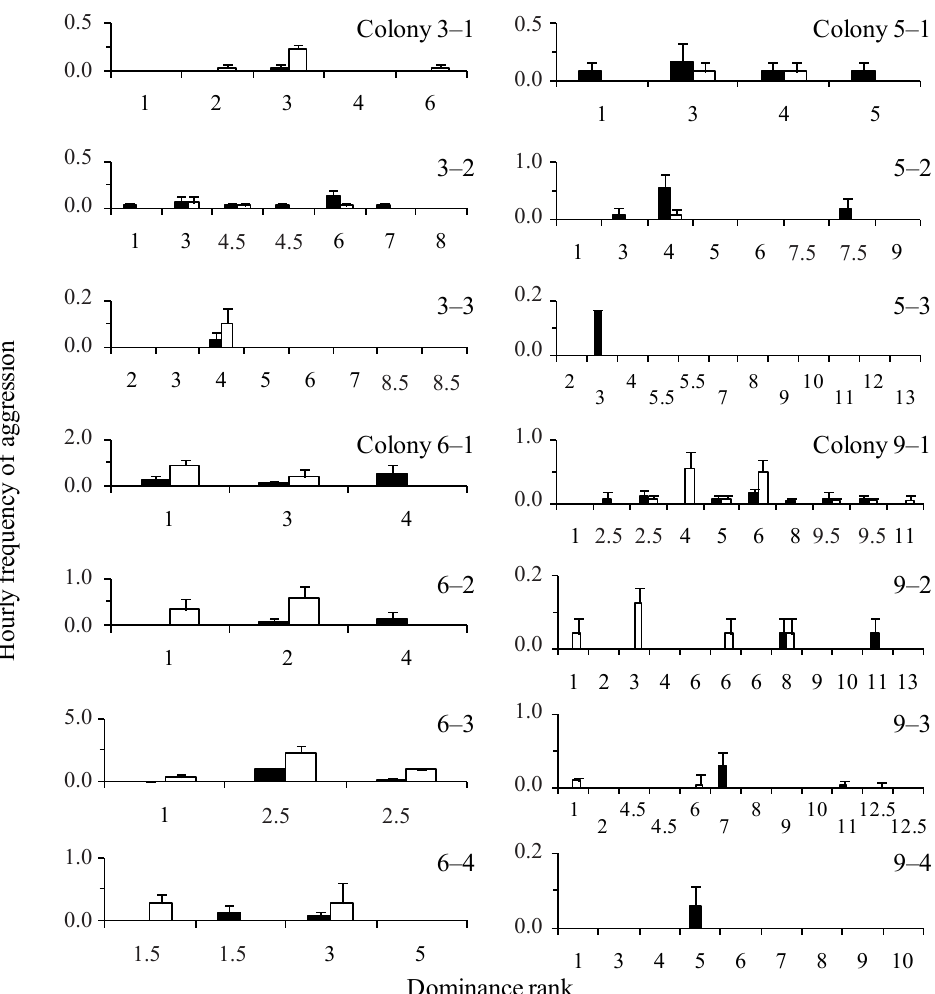
Dominance Fig 3. Hourly frequencies (means and SE values) of the aggressive behaviors that the queen exhibited toward (solid) and received from (open) individual workers, who are ordered according to their dominance ranks based on the DI. The missing dominance rank for each analysis period indicates the queen’s rank. Table 3. Comparison of proportions of ovipositing females among ones performing abdominal rubbing and those among nonperformers. Abdominal rubbing Colony Performers Nonperformers 3 3/3 3/4